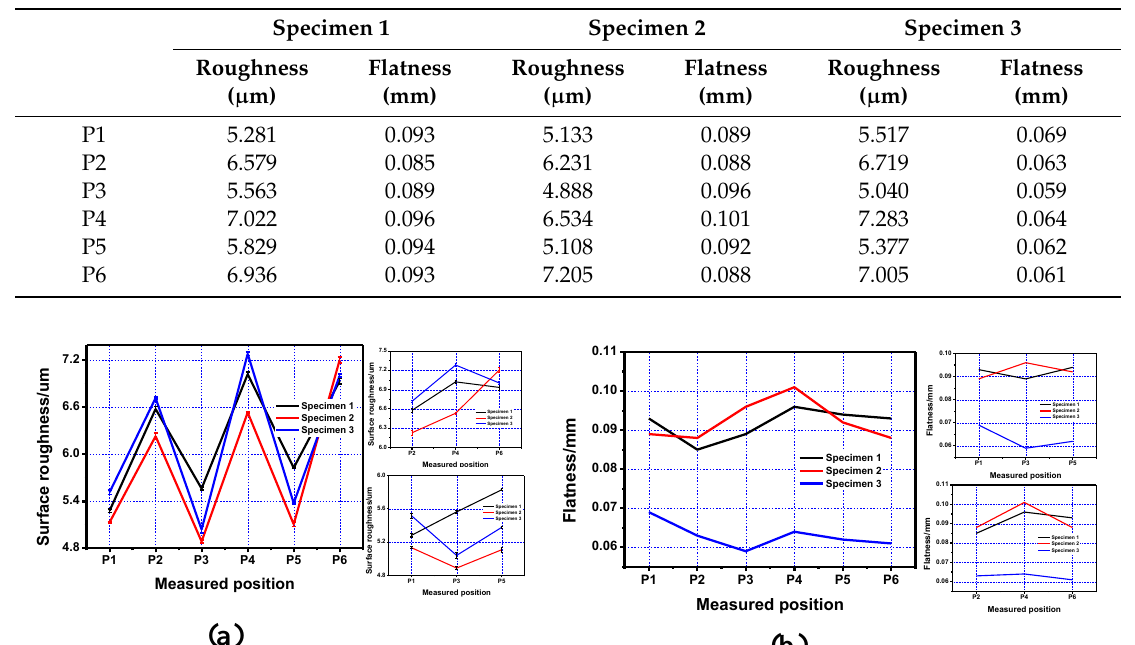
Table 3. Roughness and flatness on the positive surface of the inner structure part.